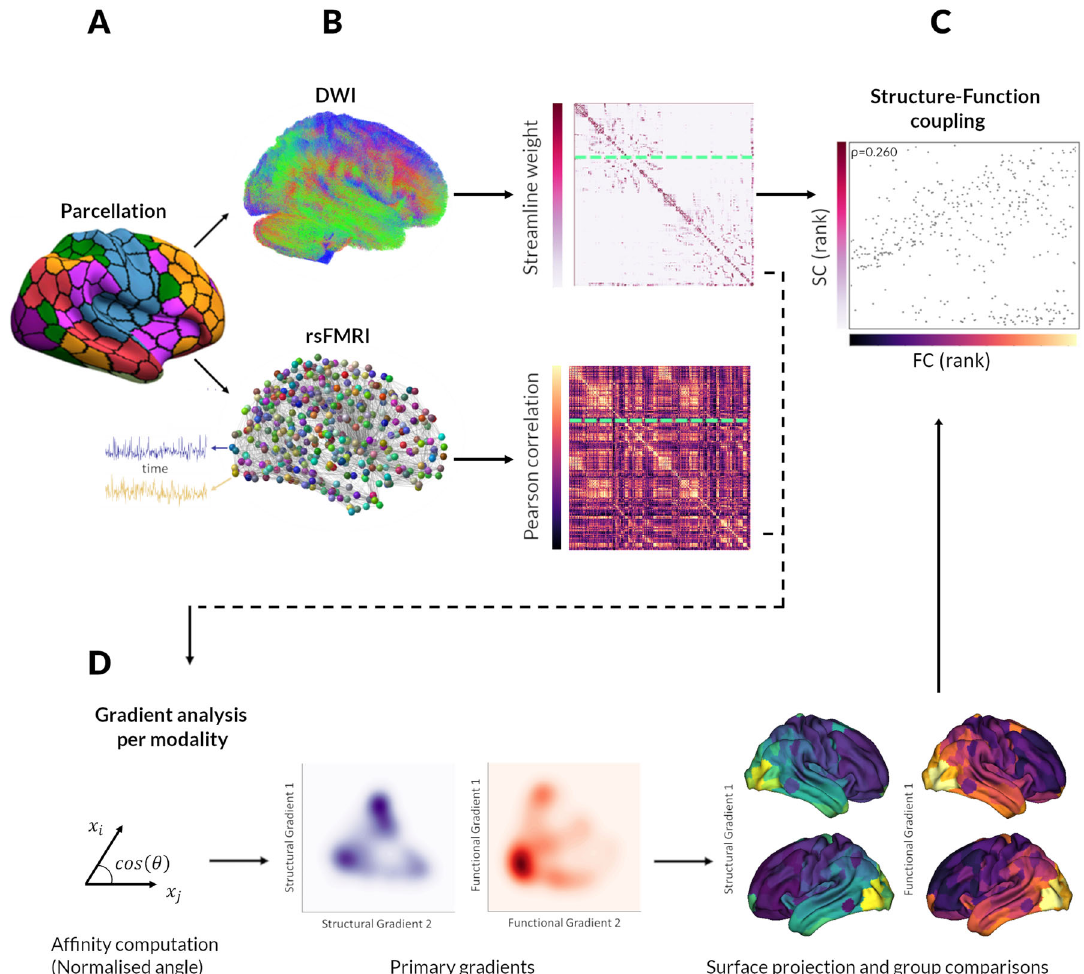
Fig. 1 Overview of the study methodology. A Analyses were conducted using a whole-brain parcellation including 400 cortical regions 42 . B Structural connectivity (SC) and functional connectivity (FC) matrices were derived for each participant from diffusion-weighted imaging (DWI) and resting-state functional MRI (rsfMRI) data, respectively. SC: Darker colours indicate higher normalised streamline counts; FC: lighter colours indicate higher Fisher-z normalised Spearman correlation values between every possible pair of brain regions. C For each participant, regional connectivity pro fi les were extracted from each row of the structural or functional connectivity matrix (example here shown by green dashed line) and represented as vectors of connectivity strength from a single network node to all other nodes in the network. Structural – functional connectivity coupling (SC – FC coupling) was then measured as the Spearman rank correlation between non-zero elements of regional structural and functional connectivity pro fi les. SC – FC coupling was then compared between groups. D Gradients of connectivity covariance were constructed for each individual ’ s structural and functional connectivity matrices using diffusion map embedding, a non-linear compression algorithm that sorts nodes based on af fi nity (normalised angle was used as a measure of af fi nity). We focused our analyses on the fi rst 2 principal structural and functional gradients; the scores of each node for the fi rst 2 gradients are shown in the kernel density plot (blue: structural, red: functional gradients). Gradient scores and SC – FC coupling may be projected back to the cortical surface. We then correlated functional and structural gradient scores with SC – FC coupling for each